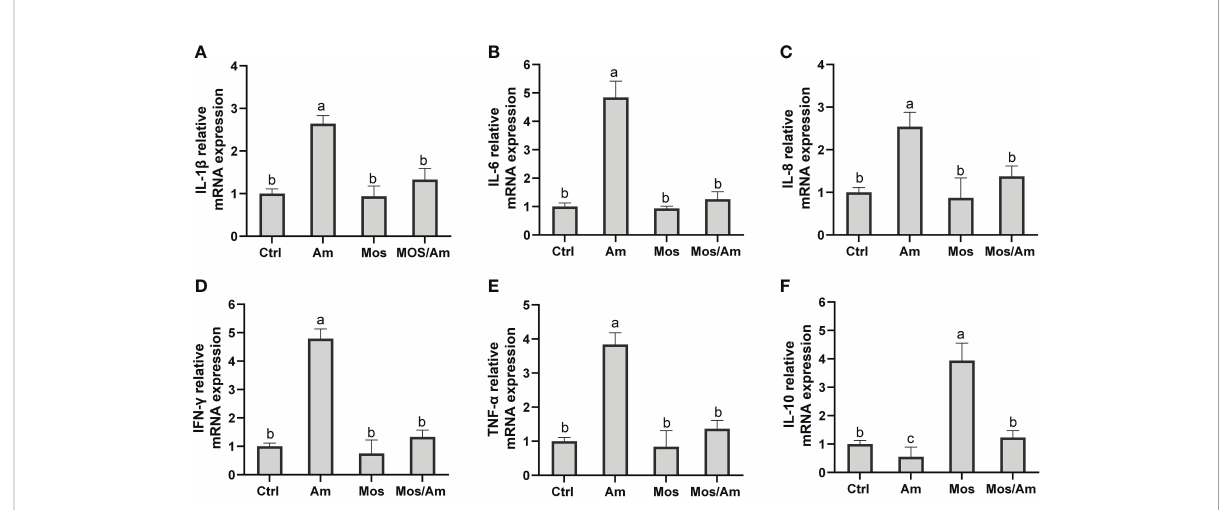
FIGURE 6 Effects of dietary MOS on the mRNA expression of in fl ammatory genes of the common carp under ammonia stress for 30 days. Values are expressed as mean ± standard error (SE) from triplicate groups. Bars with different letters differ signi fi cantly from those of other groups (P <